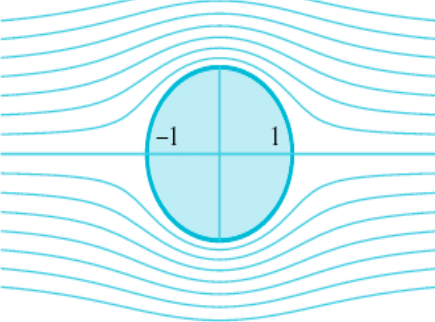
Figure 11. Fluid flow around a circular obstacle.